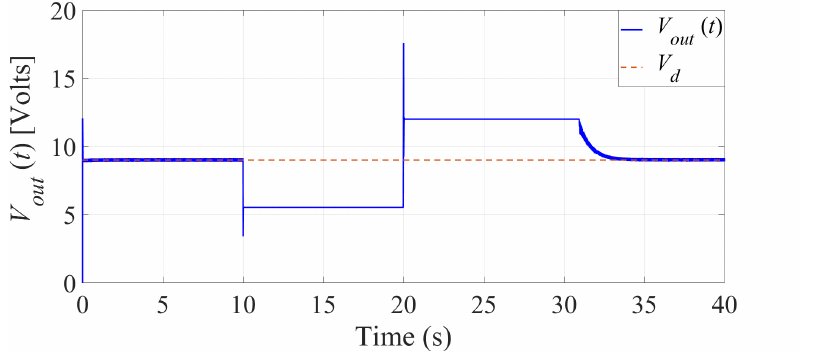
Figure 14. Scenario 2: Output voltage ( V out ( t ) ) implementing a classical PID controller (simulation